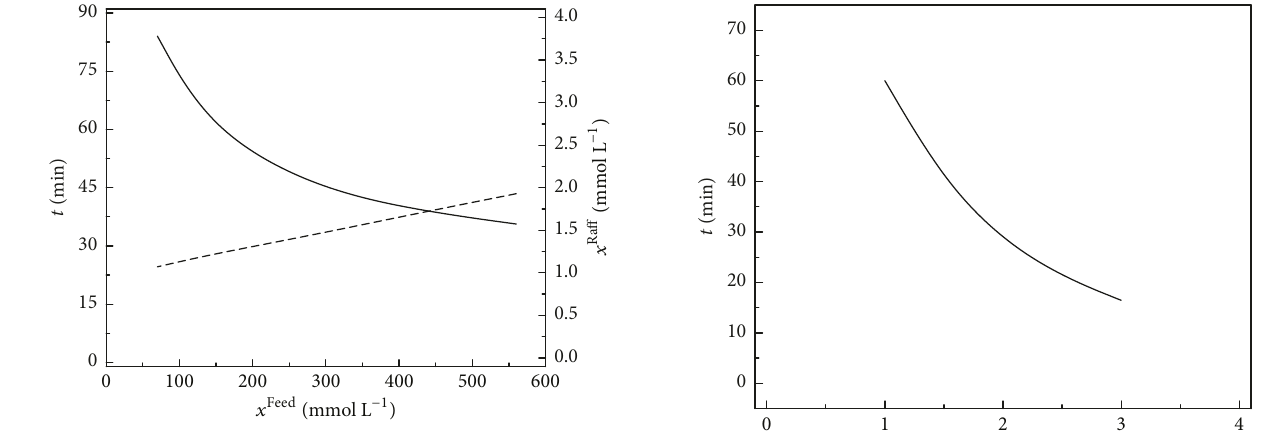
Figure 11: Adsorption unit cycle time (solid line) and raffinate concentration (dashed line) as a function of the initial concentration of the impurity in the oil phase ( 𝑥 Feed ), for a required residual concentration at the outlet of the adsorption column ( 𝑦 break ) of 1.40 mmolL −1 .